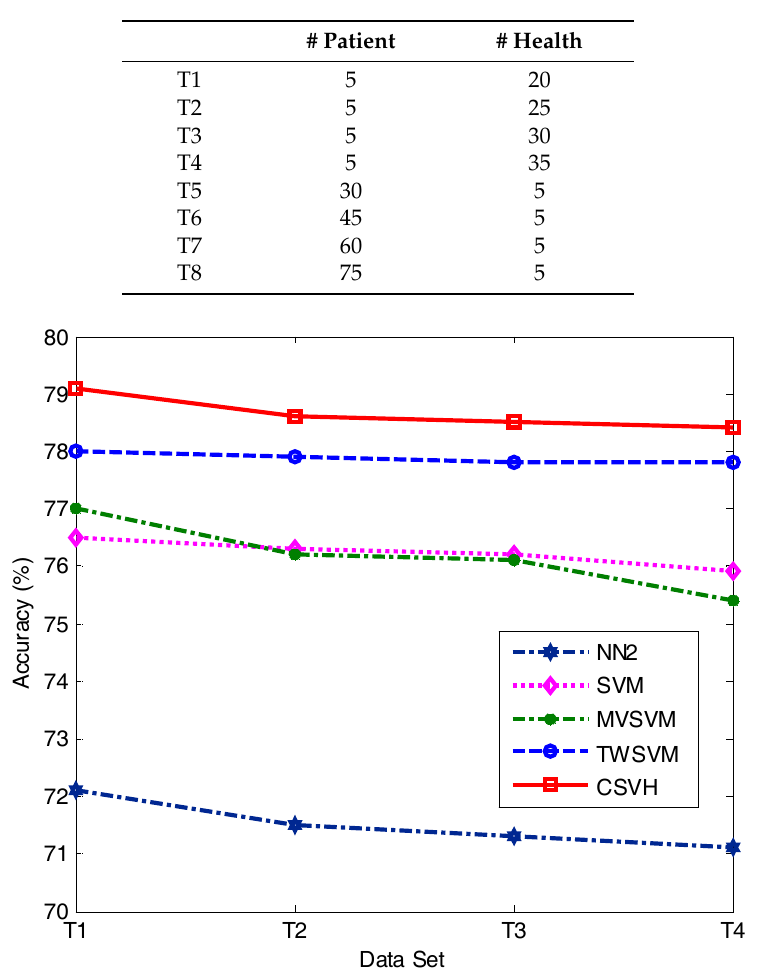
Figure 7. Classification accuracy of T1, T2, T3, and T4.